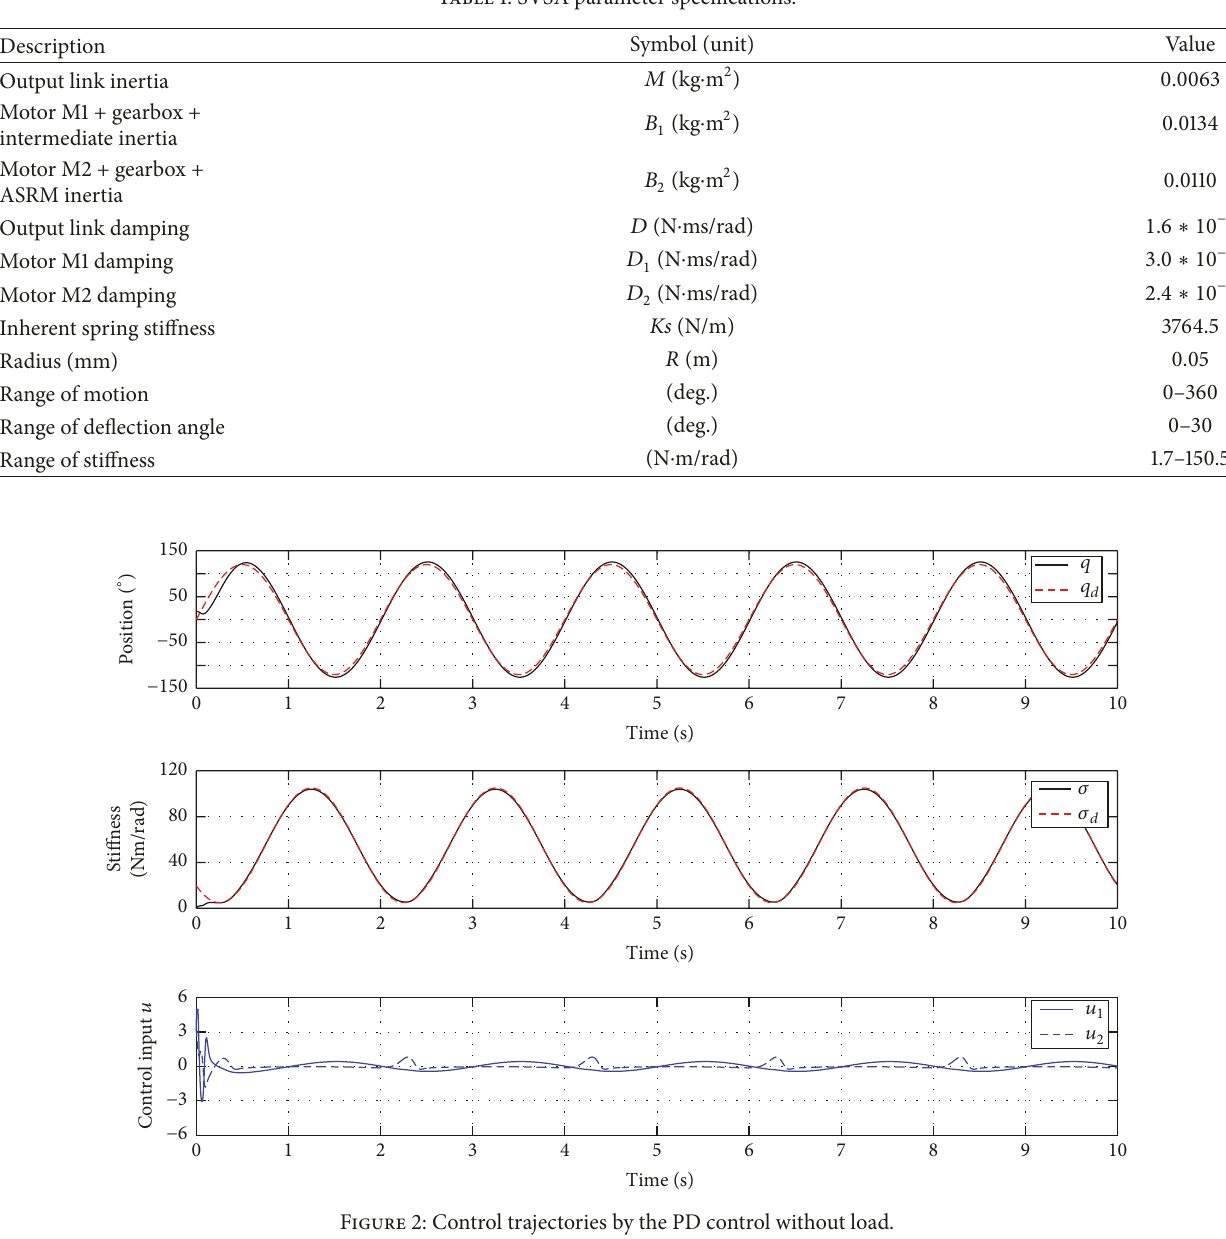
Table 1: SVSA parameter specifications.